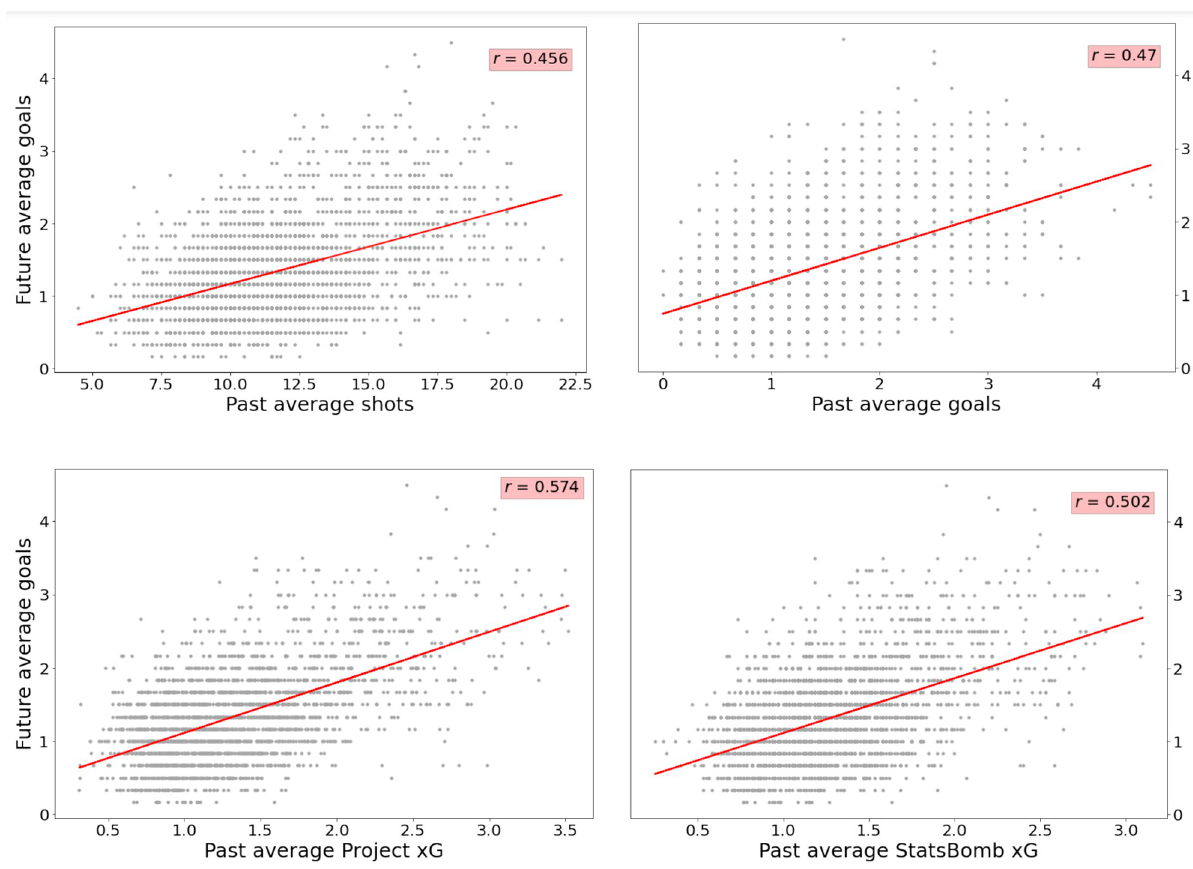
Fig 10. Statistics from all leagues data plotted against future average goals. The differences between each metric’s ability to predict future goal ratio are examined by plotting the best fit line through each statistic’s values (from all leagues combined) against average goals over the subsequent six matches and calculating Pearson’s r to deteermine their level of